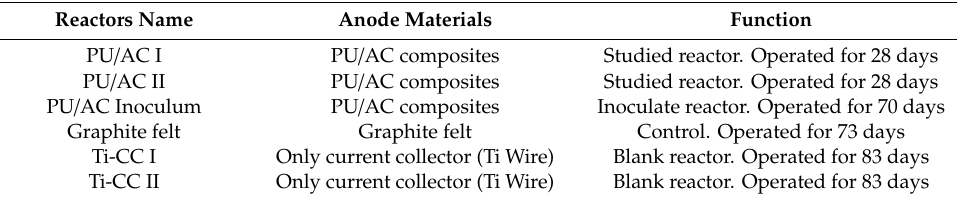
Table 1. MFC reactors name with their anode materials and